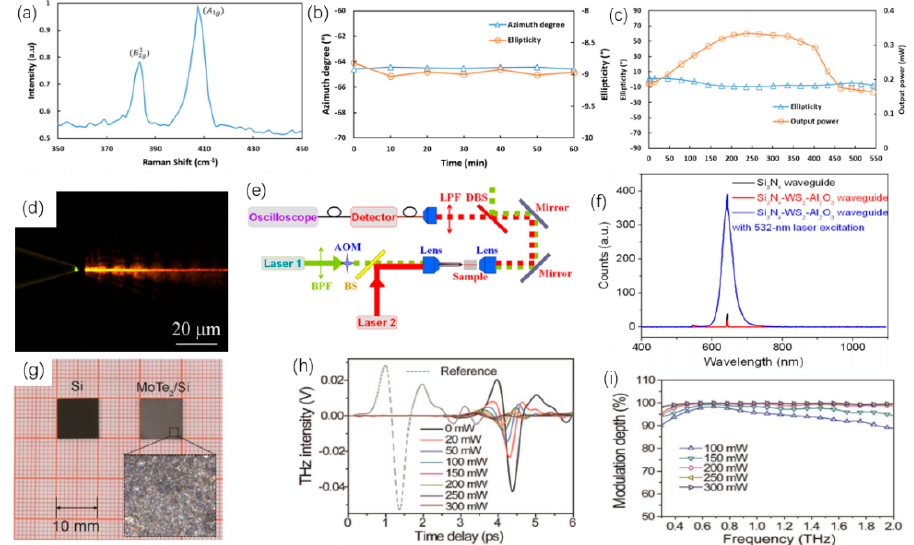
Figure 9. ( a ) Raman spectroscopic characterization of the prepared MoS 2 film. ( b ) The change curve of the azimuth and ellipticity in a period. ( c ) The relationship curve of ovality, output power, and pump power [259]. Copyright 2019 Elsevier B. V. ( d ) The microscopic image of Si 3 N 4 -WS 2 -Al 2 O 3 illuminated by a light source. ( e ) Structure diagram of the test platform. ( f ) Spectra of several modulator materials with laser excitation [261]. Copyright 2017 American Chemical Society. ( g ) Image of silicon substrate and MoTe 2 /Si. ( h ) THz spectrum with different power laser irradiation. ( i ). Modulation depth map with different laser power in 0.3–2.0 THz [261]. Copyright 2020 John Wiley and Sons